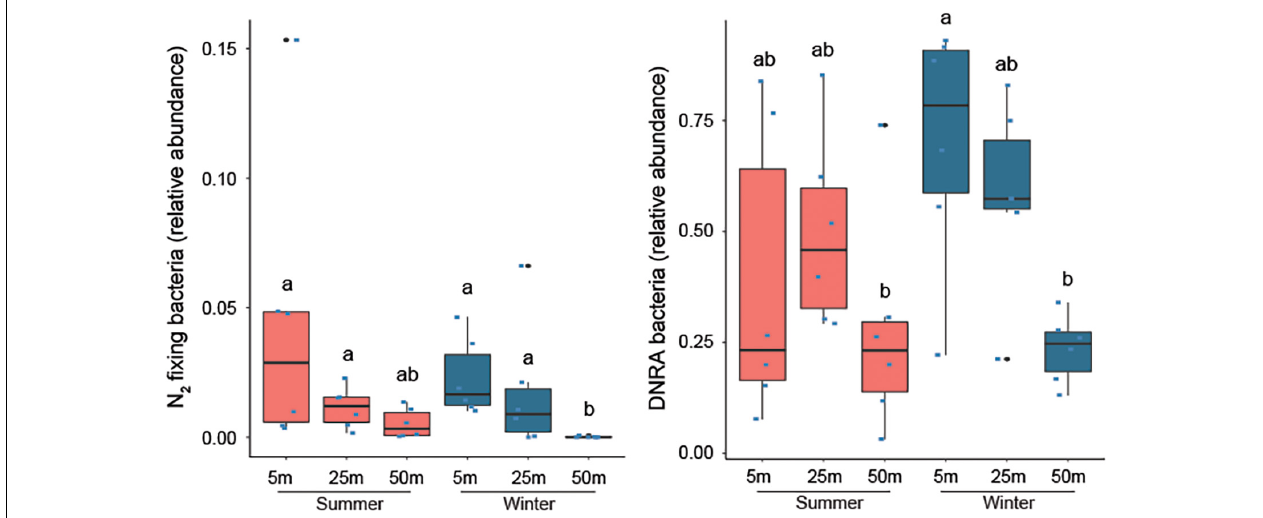
FIGURE 5 | Relative abundance of bacteria putatively capable of N 2 fixation and dissimilatory nitrate reduction to ammonium (DNRA) associated with Stylophora pistillata corals collected along a depth gradient (5, 25, and 50 m) in summer and winter. Different lettering (a, b) above the bars indicates significant differences between samples (Generalized Linear Models; significance level: p <